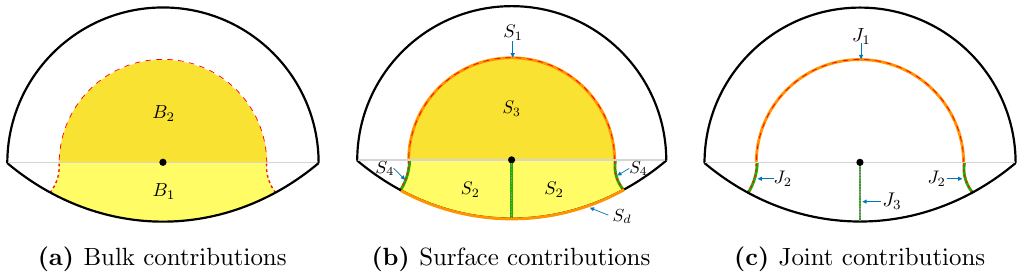
Figure 6. Di(cid:11)erent contributions for the CA conjecture projected onto a constant time slice. The bulk contributions consist of those above and below the indicated regions ( B 1 and B 2 ). The surface contributions include S 1 and S 4 which are due to the cuto(cid:11) surface and S 2 and S 3 which are due to the null boundaries of the WDW patch. S d stands for the defect contribution. The joint contributions consist of J 1 and J 2 which stand for the joints at the intersection of the cuto(cid:11) surface and the null boundaries of the WDW patch and of J 3 which stands for the joint at the ridge at the top of the WDW patch, see also (cid:12)gure